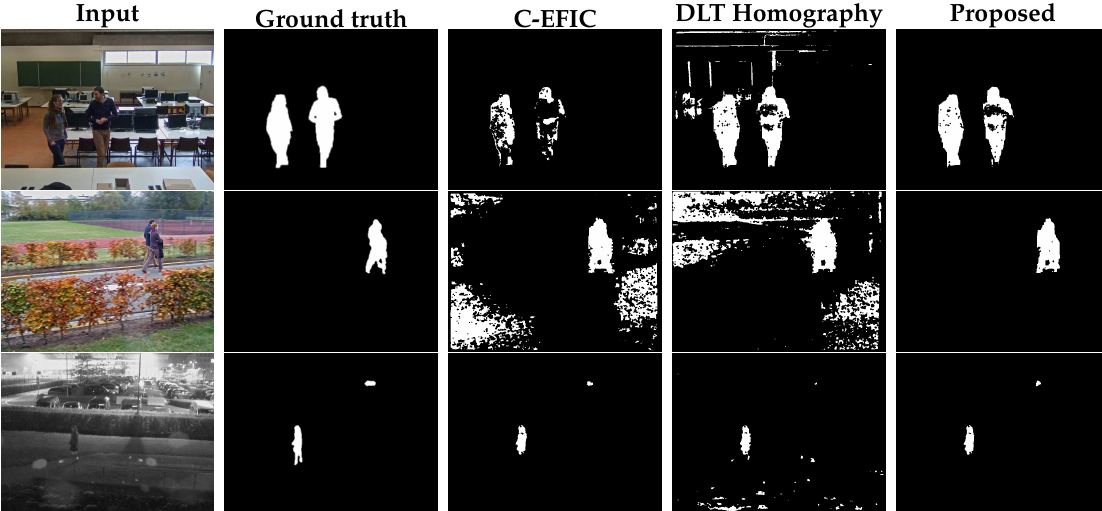
Figure 12. Foreground–background segmentation result for three handpicked simultaneous pan/tilt frames, using 12 feature points per frame. Top row: indoor sequence, middle row: outdoor day sequence, bottom row: outdoor night